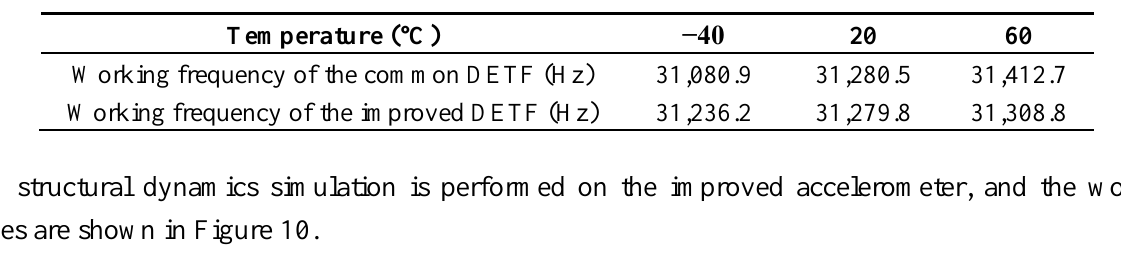
Table 3. Working frequencies of the resonators in the two types of accelerometers at different